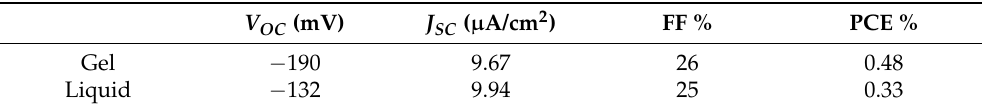
Figure 7. Electrochemical analysis and performance of PSI-sensitized solar cells (PSI-SSC) using liquid and gel Co II/III -based electrolytes. ( A ) Dark and white light illuminated J -V curves of the fabricated devices using liquid and gel electrolytes. ( B ) Representative chronoamperometry experiments measured at different white light illumination intensities. Table 4. PSI-sensitized solar cells (PSI-SSC) performance using liquid and gel-based electrolytes using aqueous-soluble Co II/III redox